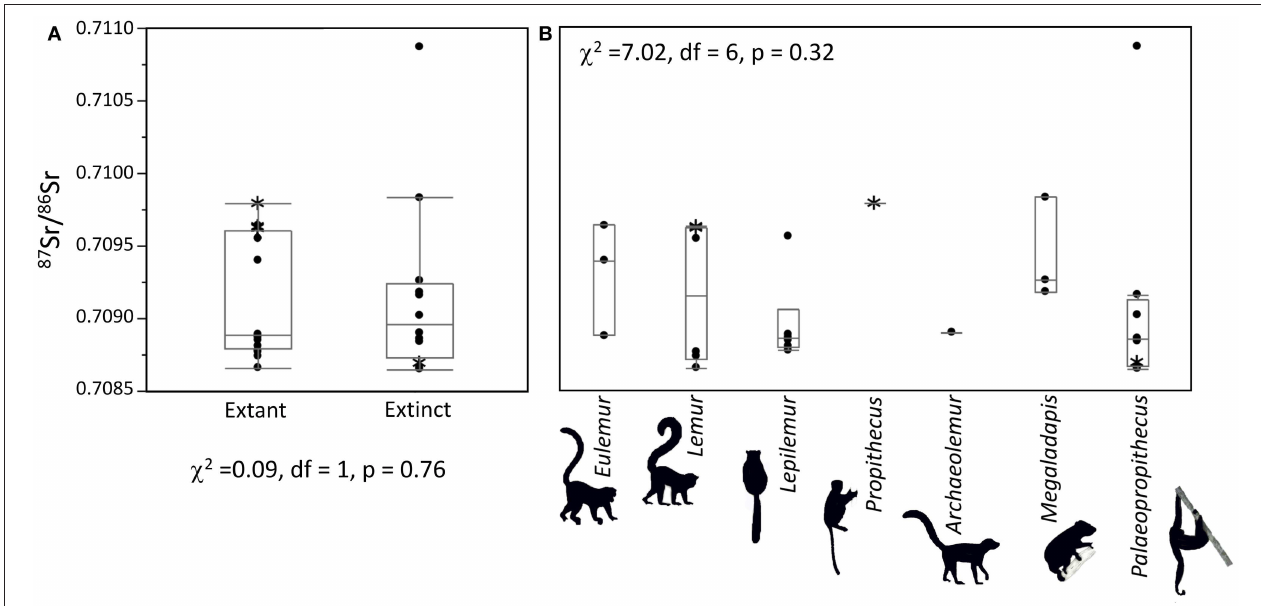
FIGURE 3 | Box plots comparing extinct and extant lemurs (A) and all genera (B) at Ankilitelo/Mikoboka. Statistical results do not change if the outlier Palaeopropithecus is excluded ( χ 2 = 1.14, df = 1, p = 0.29, and χ 2 = 2.95, df = 5, p = 0.71, respectively). Asterisks (*) indicate material from non-Ankilitelo sinkholes on the Mikoboka